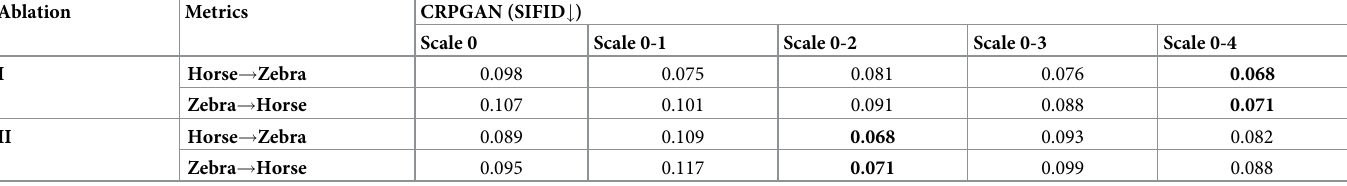
Table 4. Quantitative comparison between different scale factor η of CRPGAN in terms of SIFID. The best scores are in bold. Ablation